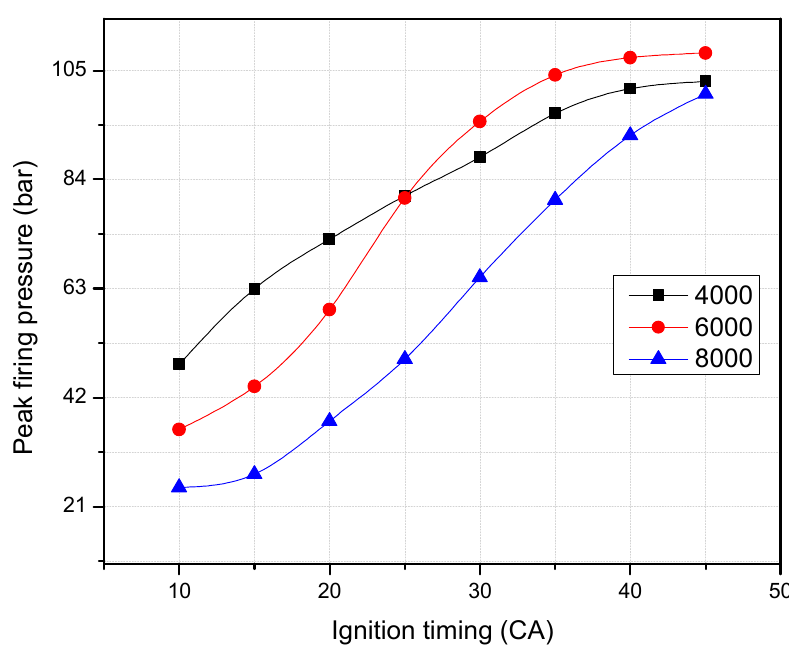
9 of 17 Figure 8. Residual gas ratio versus ignition timing. Figure 9 presents the effect of ignition timing on peak firing temperature. As the ig- nition timing increases, the peak firing temperature increases. It can be explained that when ignition timing is increased, with the lateness of the ignition timing, there will be more time for the mixture to blend better. This leads to the mixture being more evenly mixed, thereby leading to a complete combustion. The maximum peak firing temperature was 2993.26 K at 45 °CA of ignition timing as engine speed was 6000 rpm. Figure 9. Peak firing temperature versus ignition timing. Figures 10 and 11 illustrate the impact of ignition timing on peak firing pressure and peak pressure rise. The peak firing pressure and peak pressure rise show the same trend with the peak firing temperature when increasing the timing of ignition. The peak firing pressure and peak pressure rise reached the maximum when the revolution of the engine